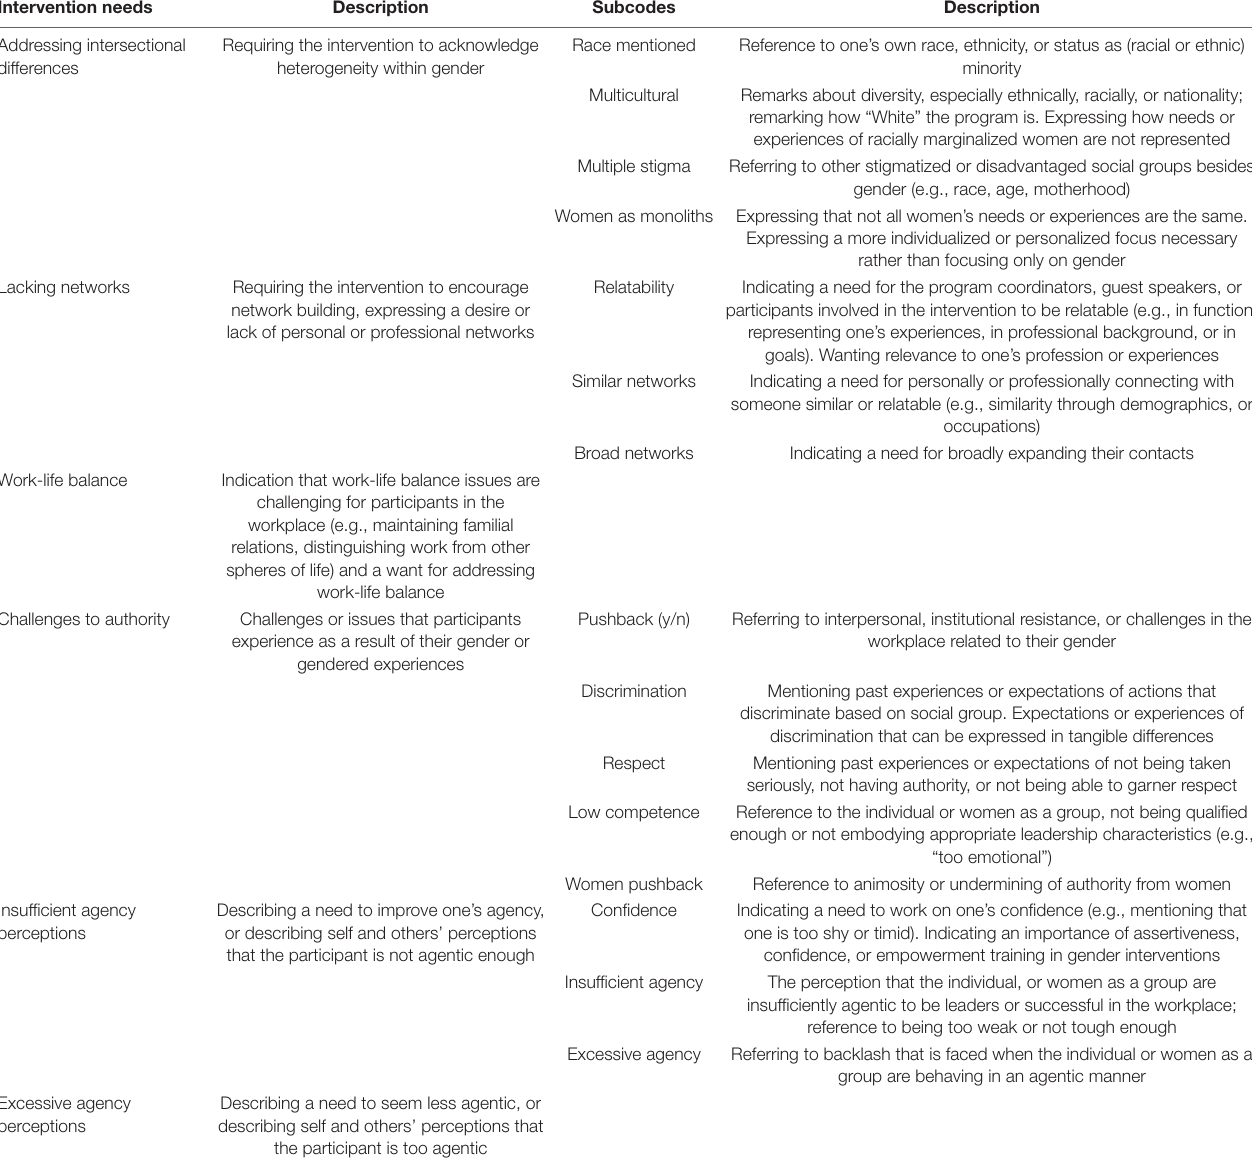
TABLE 1 | Codebook for intervention